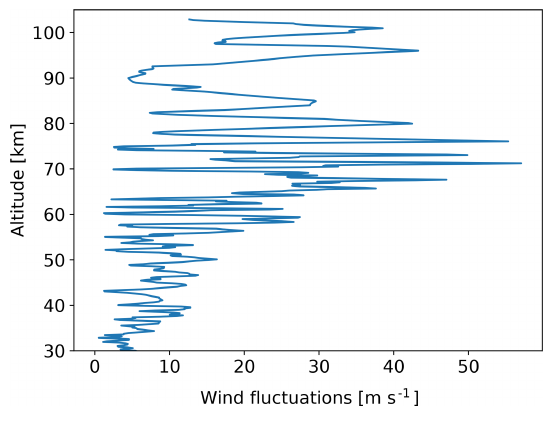
p u (cid:48) 2 + v (cid:48) 2 , where u (cid:48)